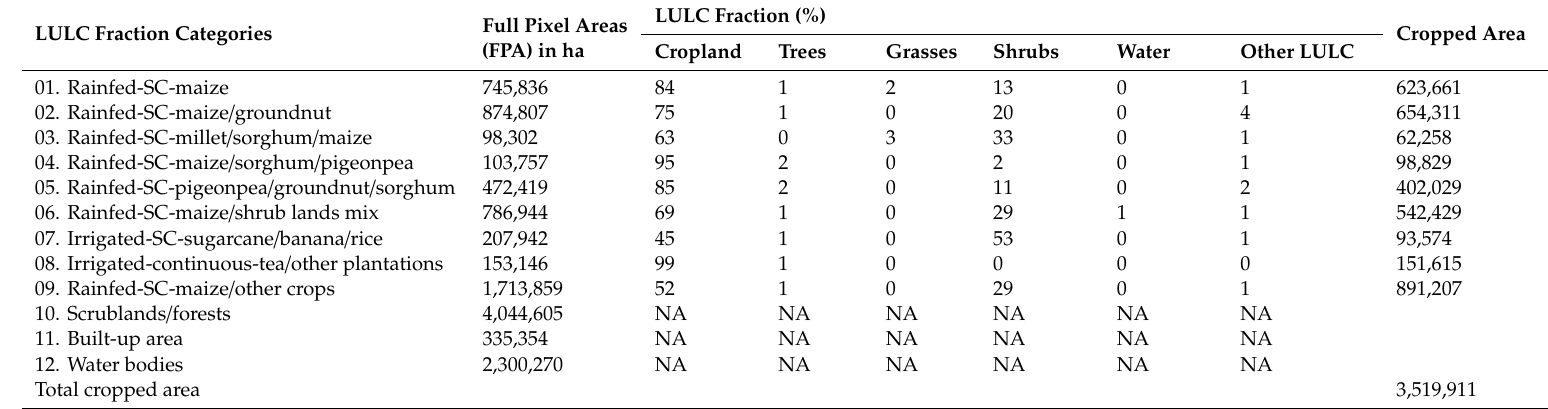
Table 2. Cropland area for each class, providing an understanding of sub-pixel fractions for the 12 final classes in Malawi for the crop year 2016-2017. LULC Fraction Categories